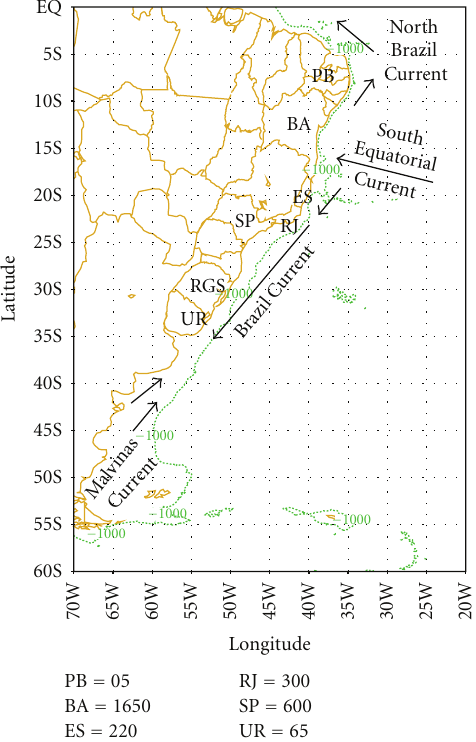
Figure 1: Schematic representation of South America coastal ocean currents and locations representing the following: UR: Uruguay, RGS: Rio Grande do Sul, SP: S˜ao Paulo, ES: Esp´ırito Santo, BA: Bahia, PB: Paraiba, and S is the city of Salvador, BA. The numbers at the left corner represent the total of penguins that arrived at those locations. The green line shows the 1000 m isobath. Adapted from